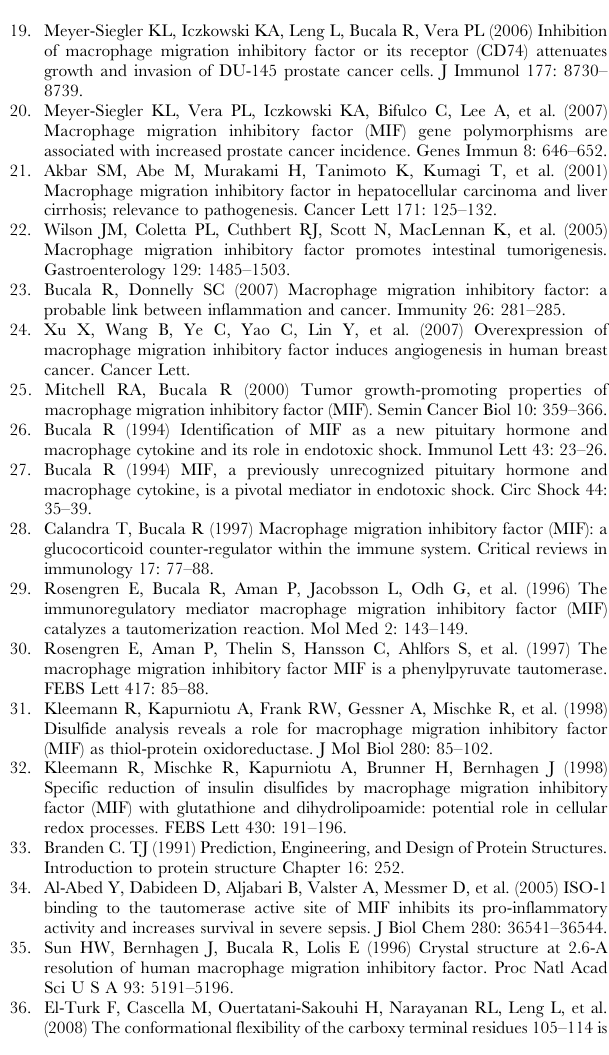
Figure S5 MIF Leishmania homologues adopt extended a -helix H1. (A) Superimposition of wt human and Leishmania MIF monomers. Note the extension of the helix H1 in the Leishmania species, in comparison to the crystal structure of the human protein. (B) Multiple sequence alignment of wt huMIF and the two species of Leishmania MIF. Residues highlighted in squares correspond to the hydrophobic pocket, while residues underlined correspond to the tautomerase enzymatic site.